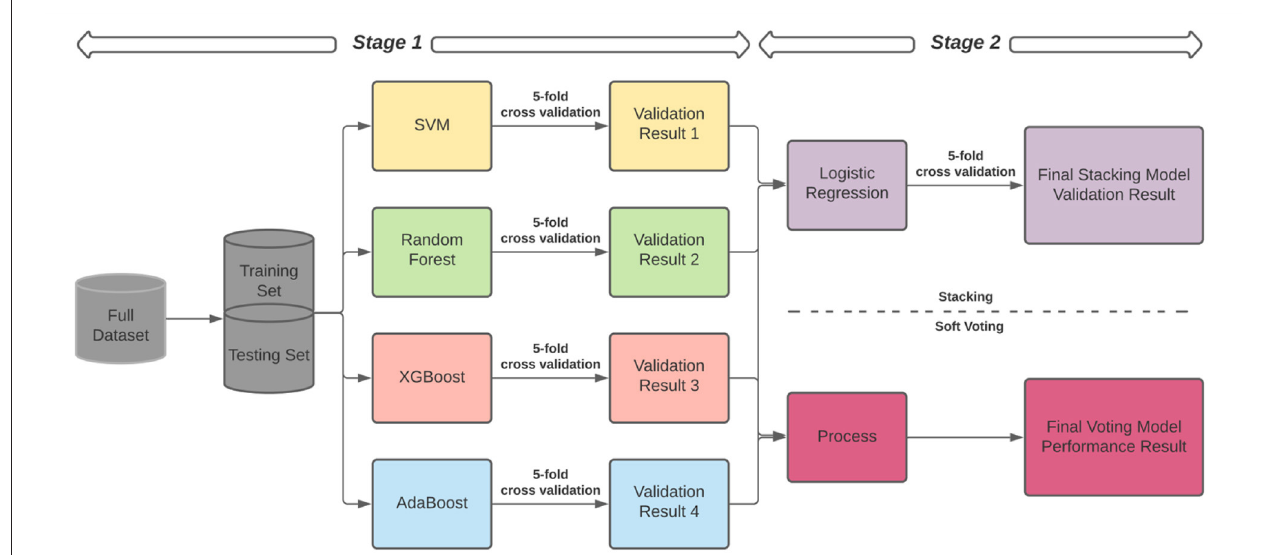
FIGURE 1 | The structures of our ensemble learning